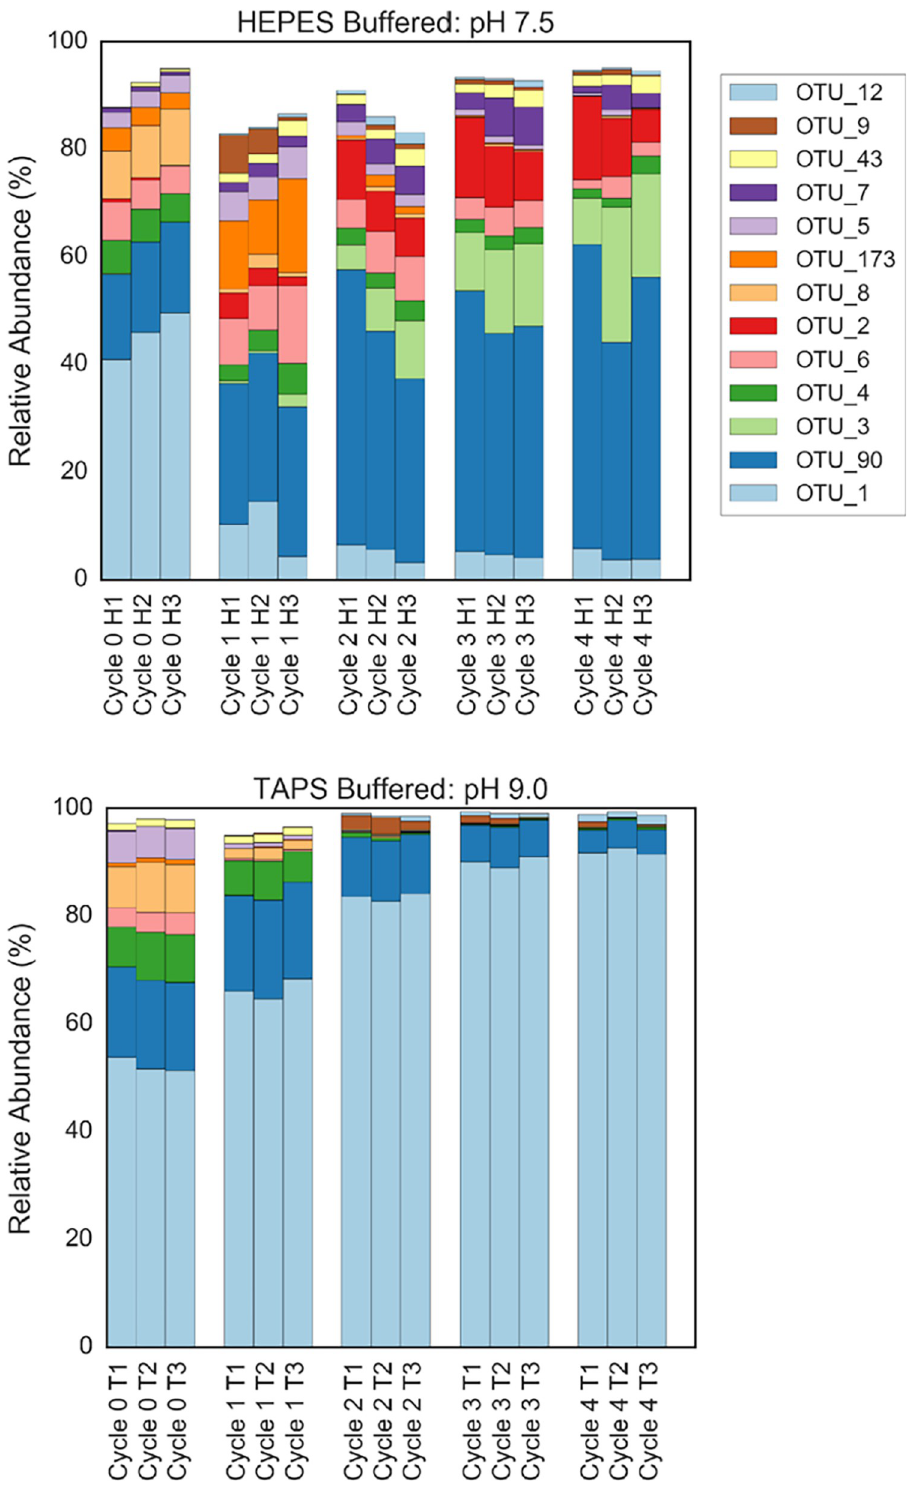
Fig 5. Microbial community composition shifts in reactors. Eukaryotic microbial community composition inferred from 18S rRNA gene sequencing in pH 7.5 reactors and pH 9 reactors, sampled at the first four resuspension (OTUs with average abundance < 0.5% removed). H1, H2, and H3 and T1, T2, and T3 represent biological triplicate reactors buffered with HEPES (pH 7.5) and TAPS (pH 9), respectively.